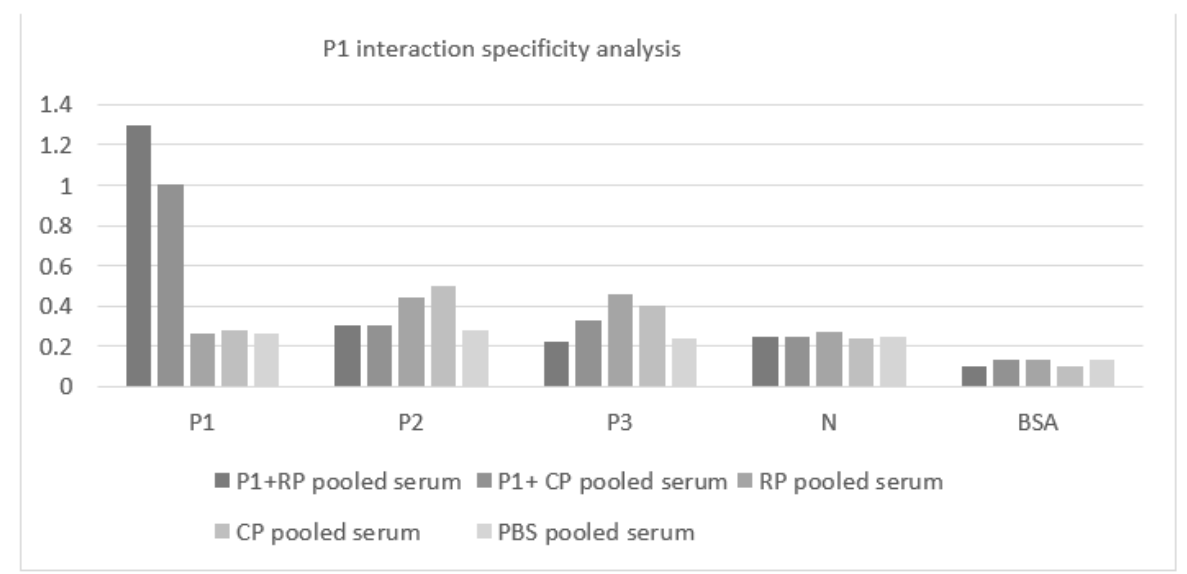
Figure 9. Analysis of the specificity of the P1 interaction: Groups of mice receiving P1+ recombi- nant/helper phages were immunized against the P1 protein and not against other unrelated proteins (P2, P3, N, and BSA). Y -axis indicates optical density. Abbreviations: RP: P1 recombinant phages, CP: control phage, PBS: phosphate buffer saline, NI: non-injected, BSA: bovine serum albumin.